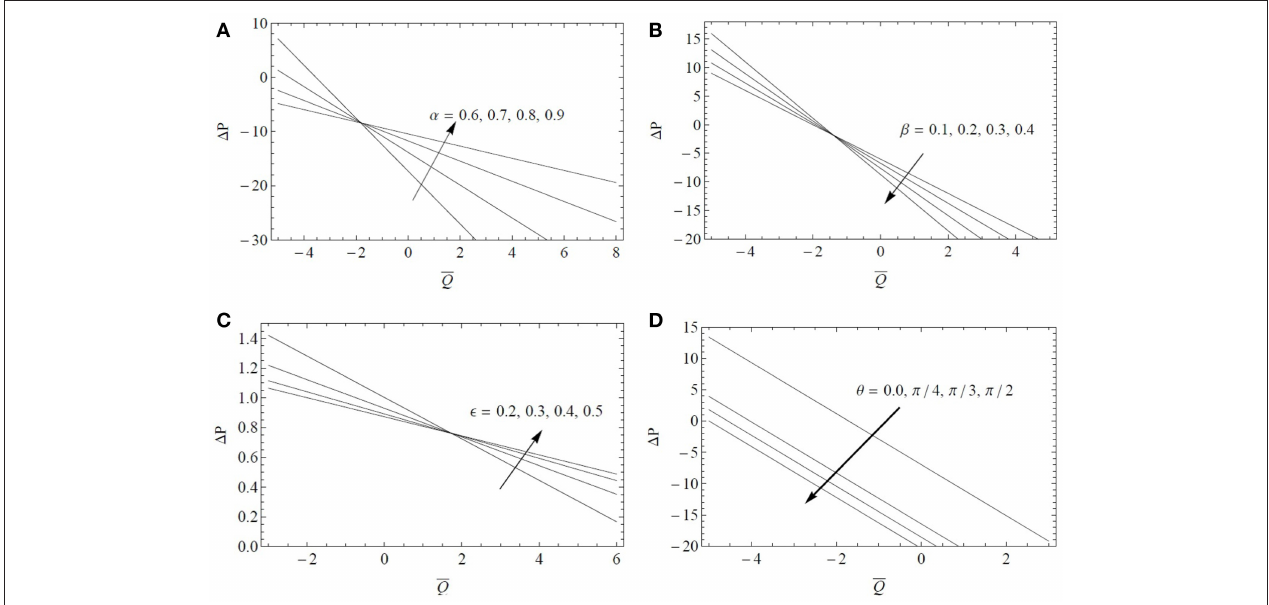
FIGURE 2 | Pressure drop 1 p as a function of the flow rate ¯ Q for α * = β * = 0.4, Fr = 0.1 and Re = 0.1: (A) influence of the fractional parameter α for ǫ = 0.3, β = 0.6, λ 1 = 5, λ 2 = λ 3 = 1, θ = π 3 ; (B) influence of the fractional parameter β for ǫ = 0.3, α = 0.6, λ 1 = 5, λ 2 = λ 3 = 1, θ = π 3 ; (C) influence of the cilia length ǫ for α = β = 0.6, λ 1 = 5, λ 2 = λ 3 = 1, θ = π 3 ; (D) influence of the inclination angle θ for ǫ = 0.3, α = β = 0.6, λ 1 = 5, λ 2 = λ 3 = 1.